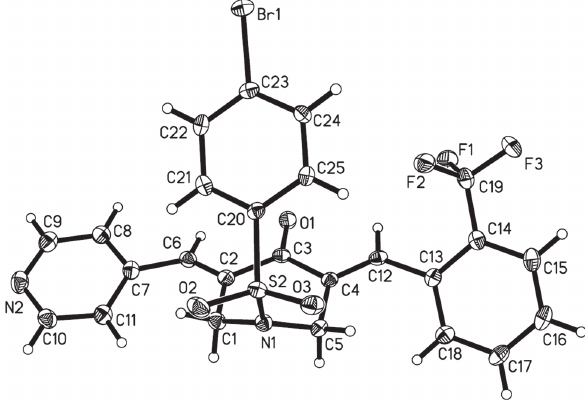
Table 2: Fractional atomic coordinates and isotropic or equivalent isotropic displacement parameters (Å 2